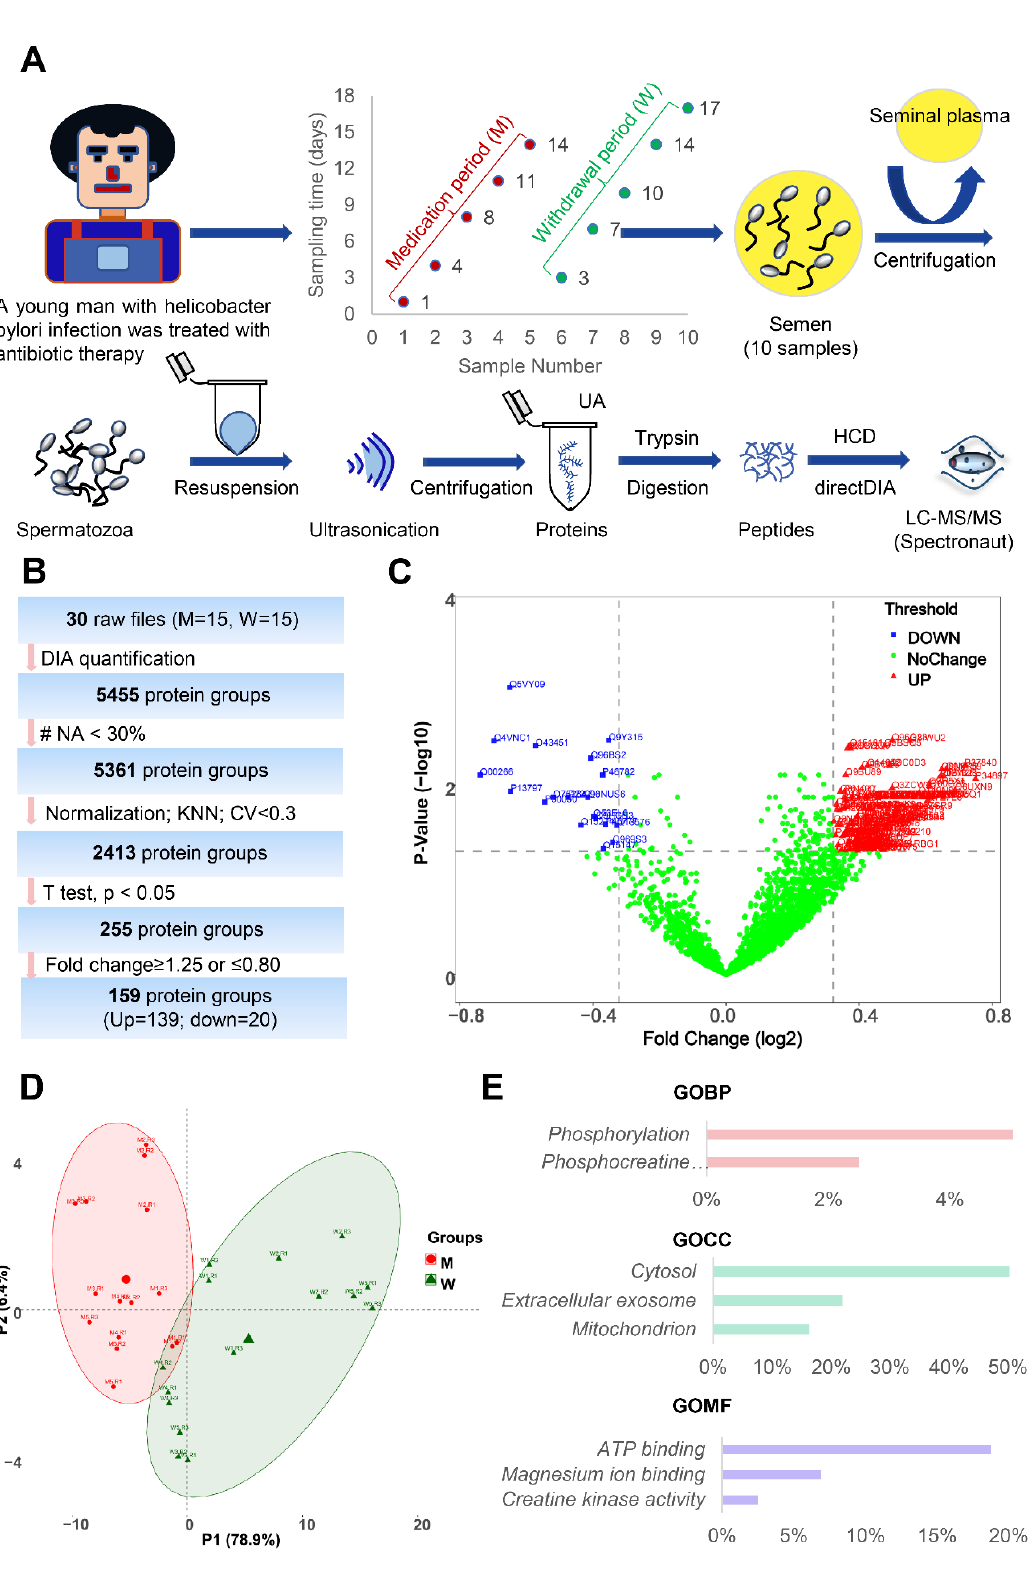
Figure 4. Quantitative proteomics analysis of human sperm after antibiotic therapy. ( A ), quantitative proteomics workflow of human sperm based on direct DIA; ( B ), analysis summary of LC-MS/MS spectral database search using strict thresholds; ( C ), volcano plot of sperm proteomic data. ( D ), PCA of differentially expressed sperm proteins; ( E ), Gene Ontology analysis of differentially expressed sperm proteins in the W group compared to the M group.